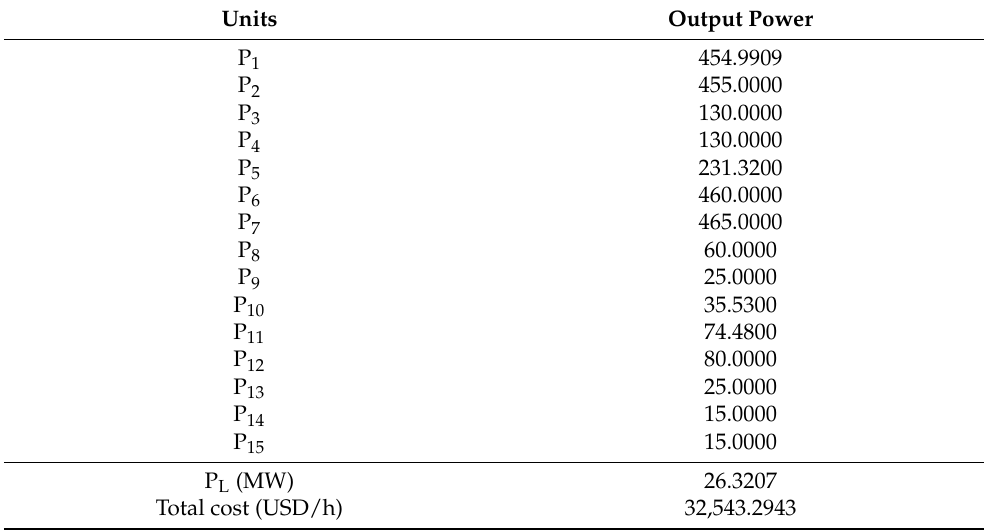
Table 7. The best decision variables for Case B-type 1 obtained by G-SCNHGWO